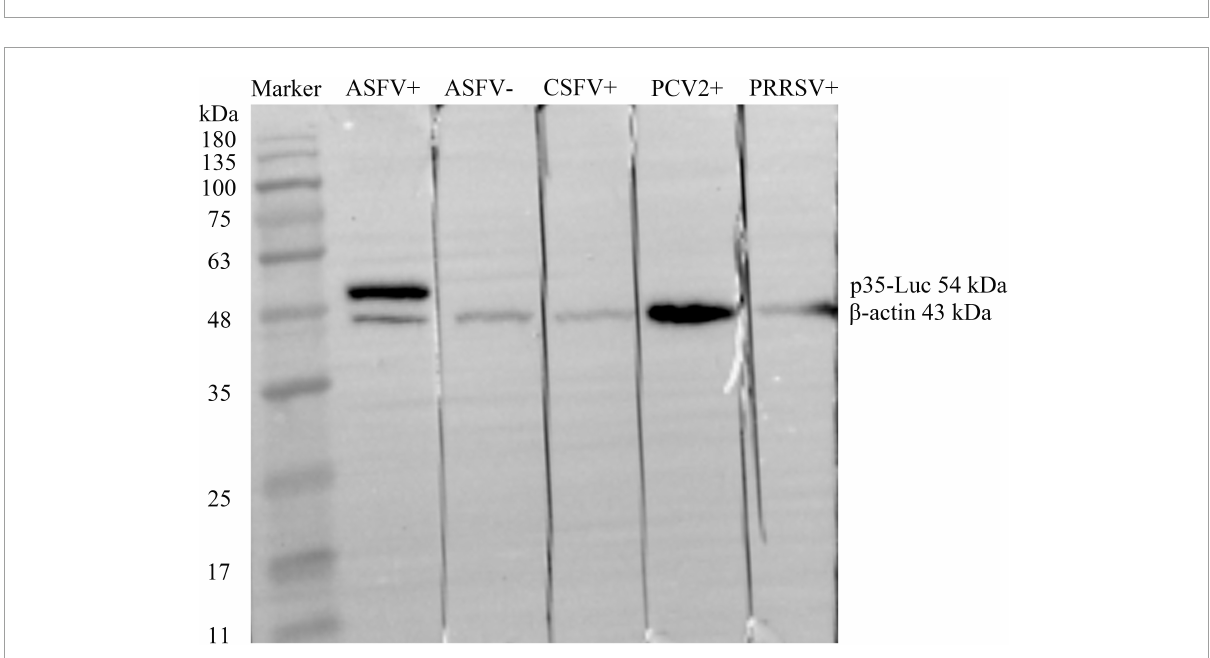
FIGURE2 The p35-Luc protein was accurately expressed and was specifically recognized by the inactivated anti-ASFV serum. The expression of p35-Luc was analyzed via Western blot with ASFV-positive serum and -negative serum. Lane 1, protein marker; lane 2, ASFV-positive serum; lane 3, ASFV-negative serum; lane 4, CSFV-positive serum; lane 5, PCV2-positive serum; lane 6, PRRSV-positive serum. The β -actin was used as loading control.